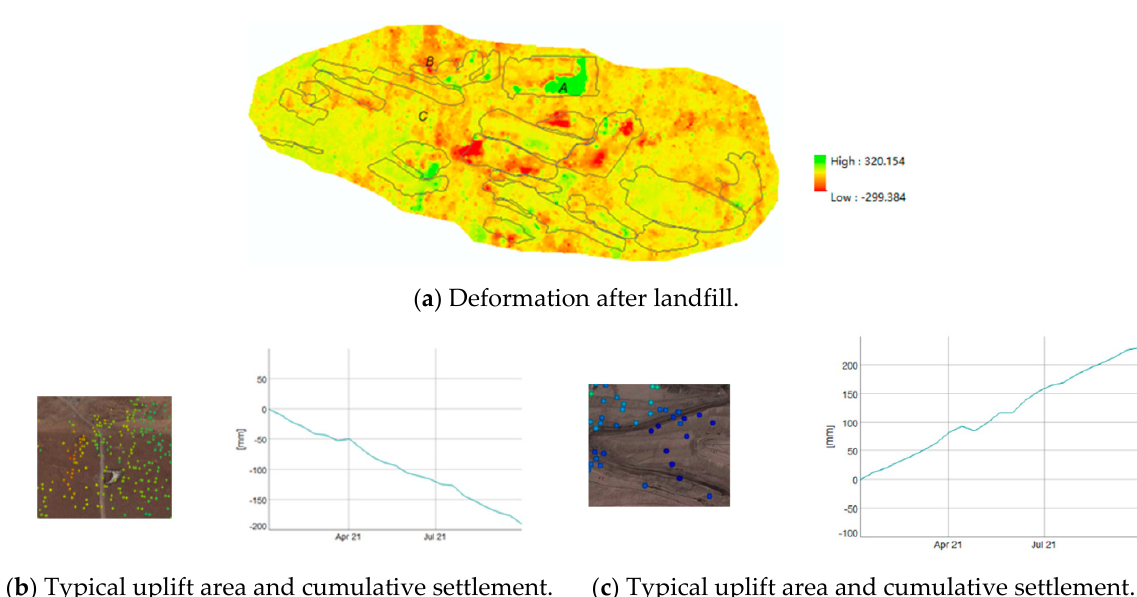
Figure 6. Deformation before landfill and three typical sites in Muli.